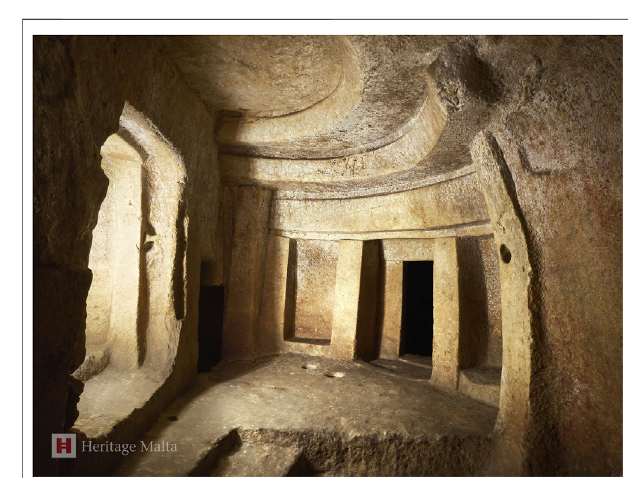
FIGURE 3 | Part of the remarkable Ħ al Sa fl ieni hypogeum, where passages and chambers were dug out to create a long-term Temple Period burial site. (Photo courtesy of Heritage Malta. Photo credit: Clive Vella. Copyright image not to be reused without permission of Heritage